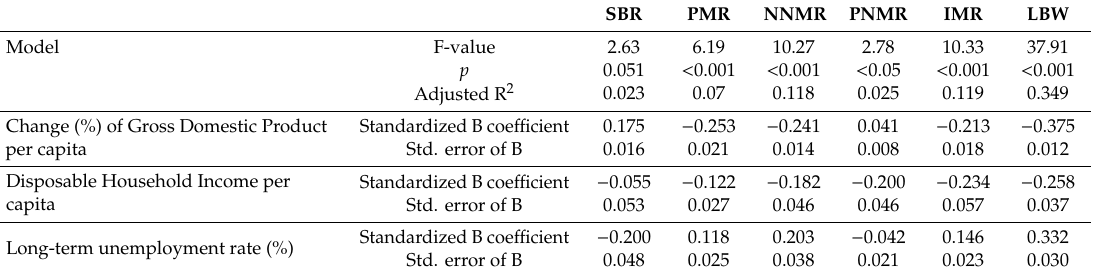
Table 4. Multiple linear regression analyses